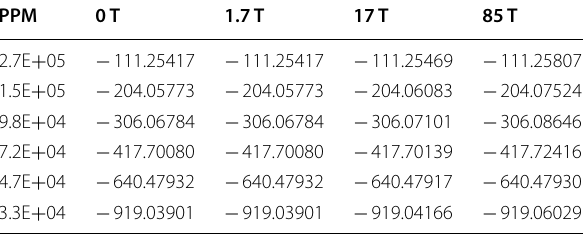
Table 4 Changes in binding energy (Hartree) of water molecules under external of magnetic field at different ppm of NaCl as seen in this table and the data are extracted from Fig.